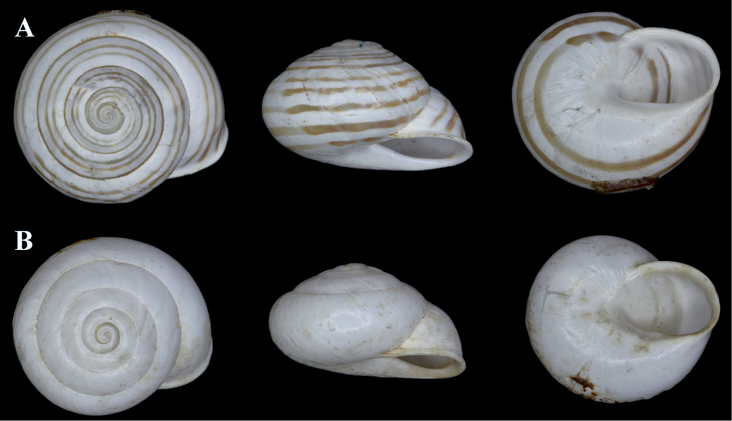
Alabastrina type specimens. AHelixsoluta, syntype MHNL 45000679, Oran, Algeria, coll. Michaud, D = 24.15 mm BHelixalabastrites, syntype MHNL 45000690, Oran, Algeria, coll. Michaud, D = 22.48 mm. All photographs by Kneubühler & Neubert, × 1.5.